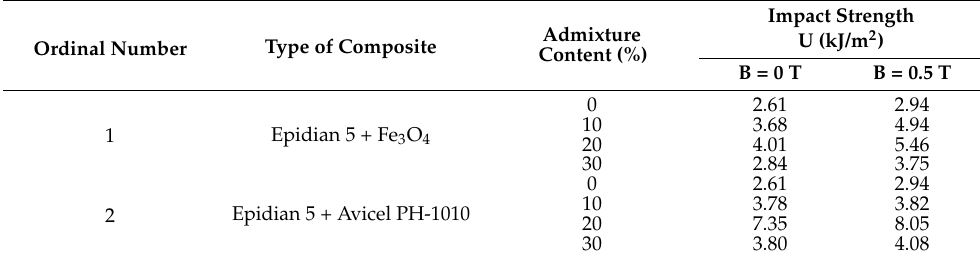
Table 15. Impact strength of selected composites.